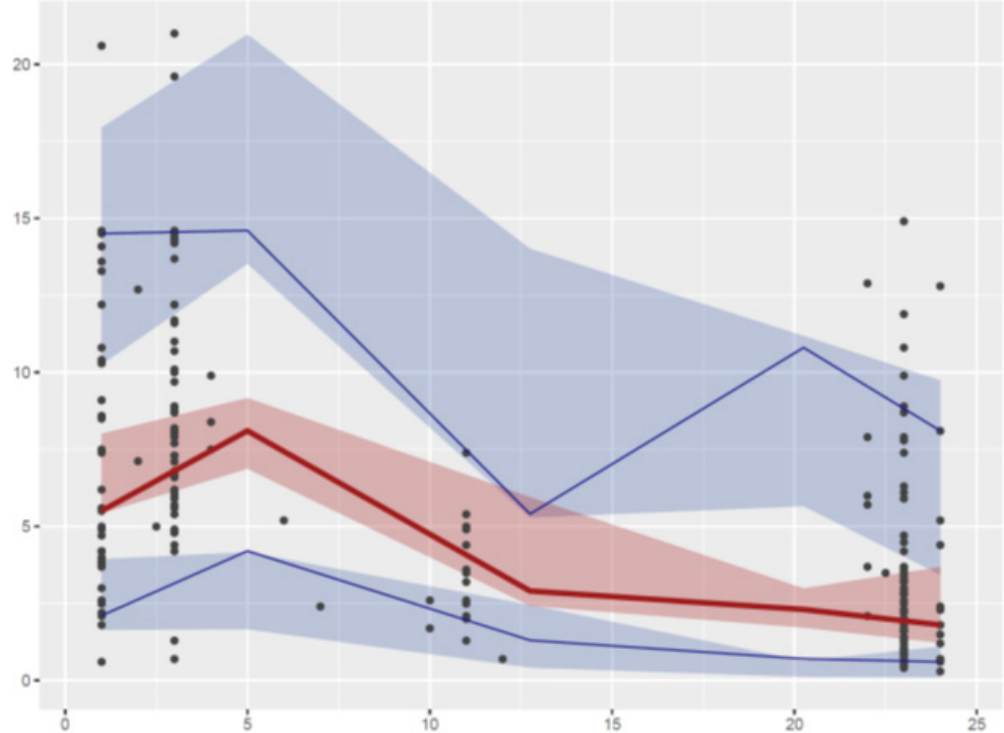
Figure 3. Visual predictive checks with the final model. Circles: observed concentrations, upper blue, median solid red, and lower blue lines: 97.5th, 50th, and 2.5th percentiles obtained from the observed concentrations, respectively. Lower blue, median red, and upper blue areas are: 95% confidence interval of the predicted 2.5th, 50th, and 95th percentiles, respectively.